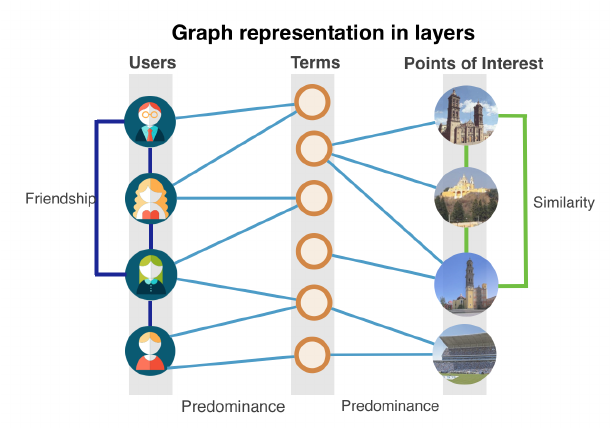
Figure 1: Graph model. Node layers: User, Term, and Points of Interest linked trough Friendship, Predominance and Similarity